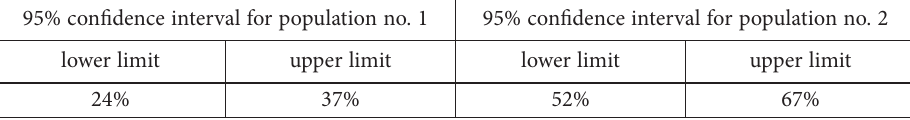
Table 6. Interval estimates of proportions enterprises making full use of the essence of controlling in the population with dominance of domestic capital – no. 1 and foreign capital – no. 2) 95% confidence interval for population no. 1